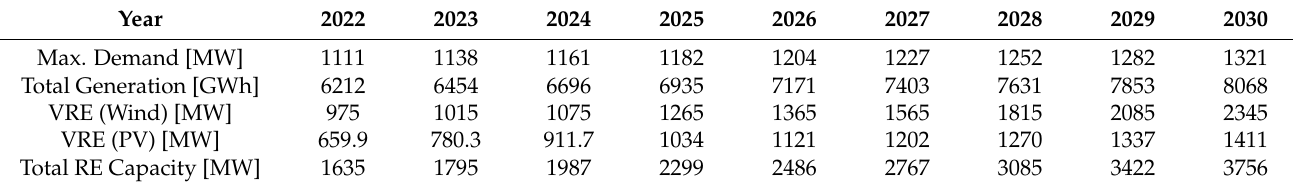
Table 6. The estimated power demand and the amount of VRE capacity of Jeju.